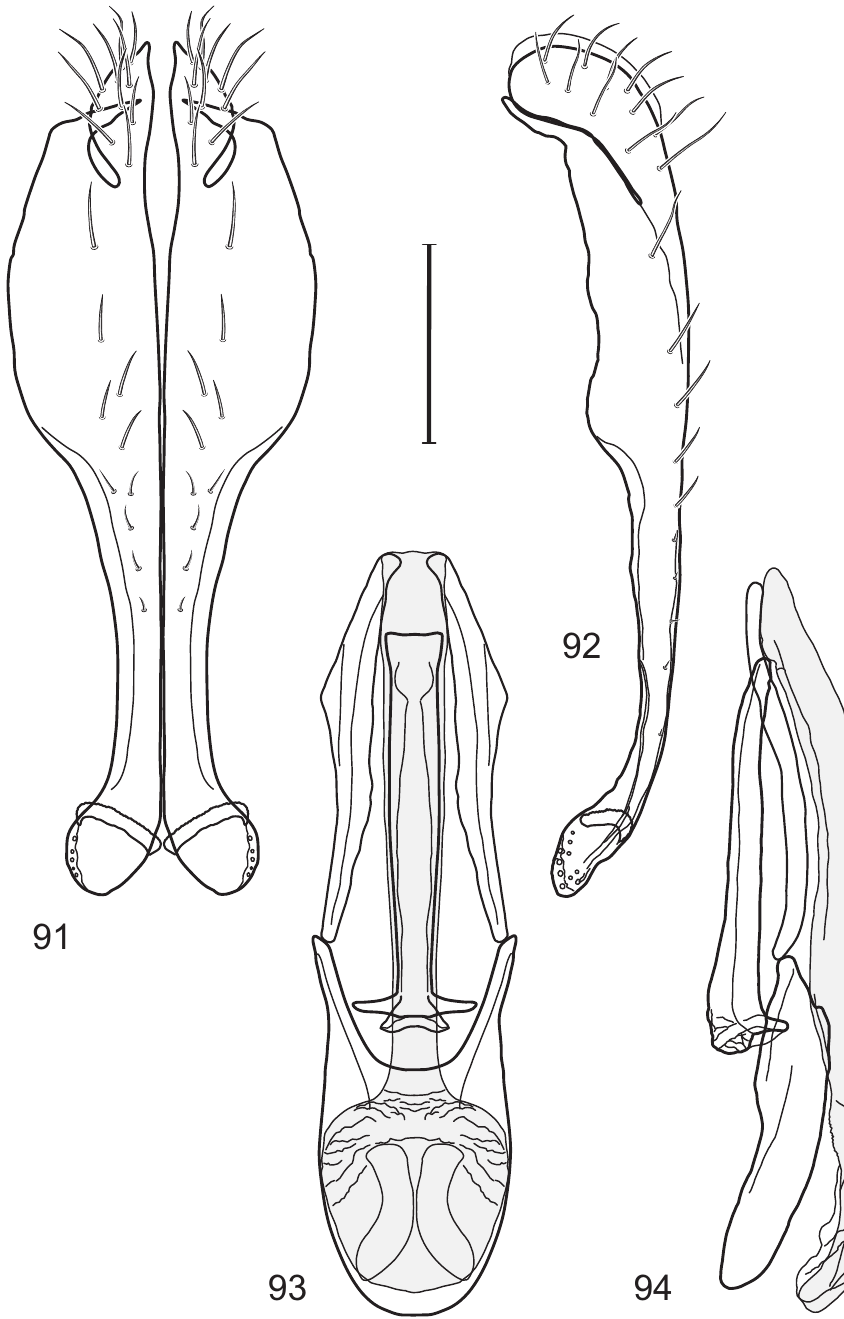
Figures 91–94. Hydrochasma incisum (Coquillett) (Peru. Cuzco: Paucartambo, Atalaya) 91 epandrium and cerci, posterior view 92 same, lateral view 93 internal structures of male terminalia (aedeagus [shaded], phallapodeme, gonite, hypandrium), ventral view 94 same, lateral view. Scale bar = 0.1